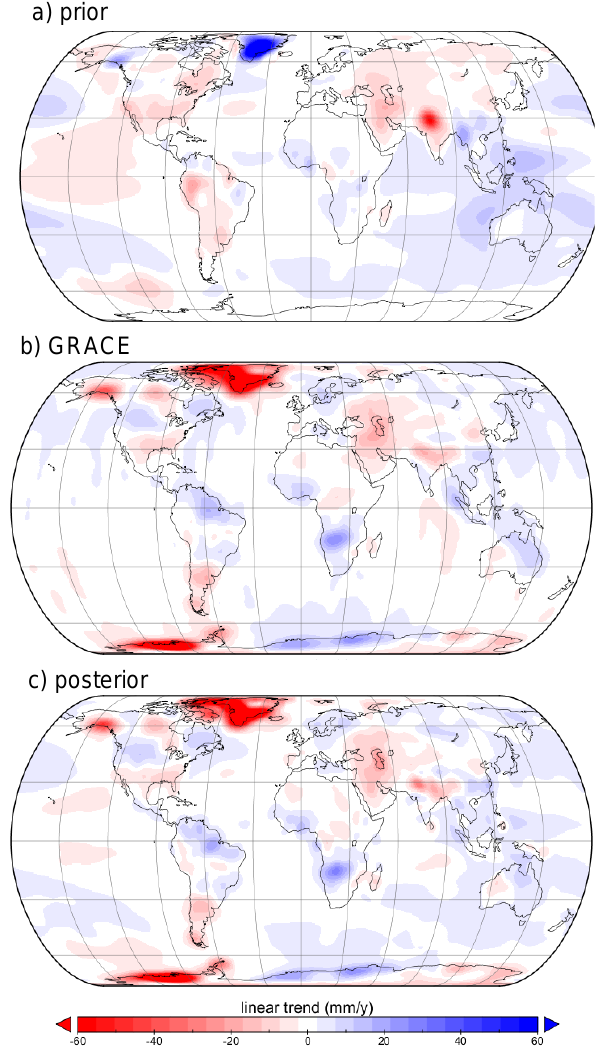
Figure 4. Trends in GRACE total water storage as derived from (a) prior storage estimates, (b) merged satellite retrievals and (c) poste- rior